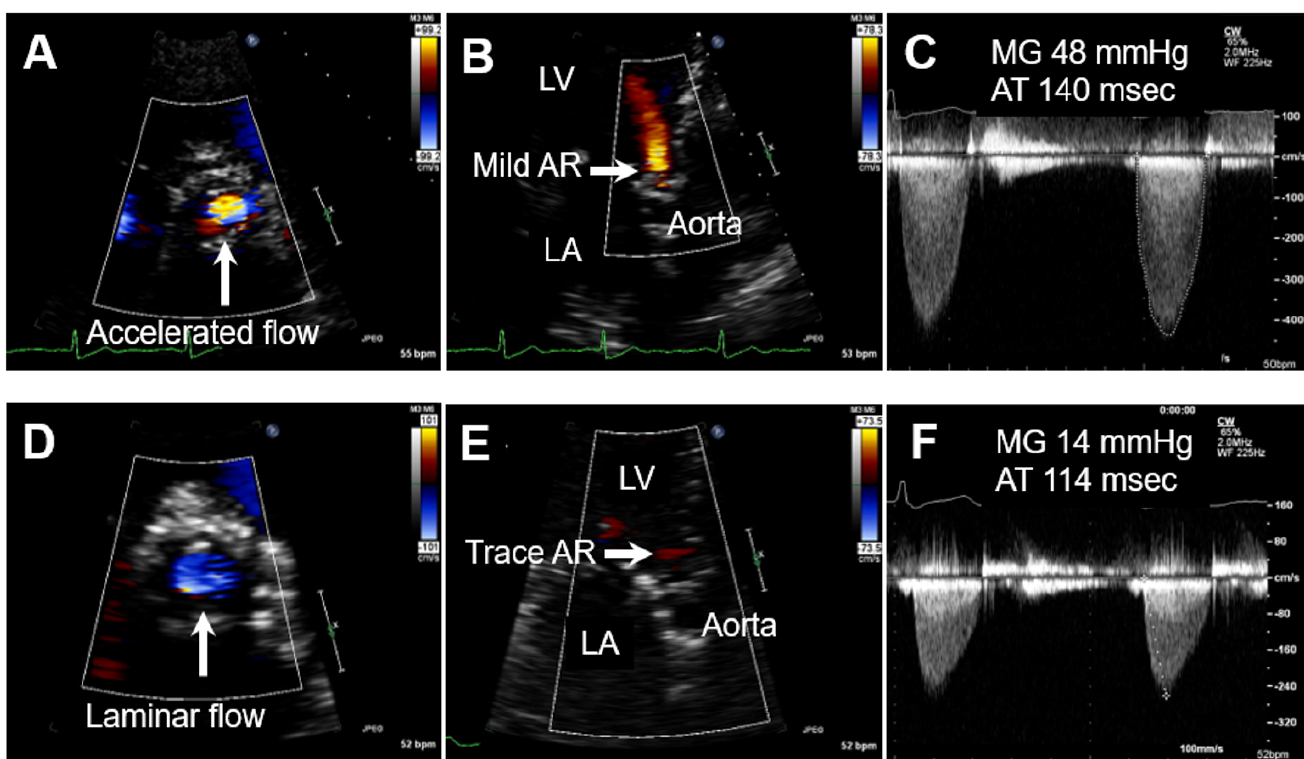
Figure 1. Transthoracic echocardiogram with CW Doppler before ( A – C ) and after ( D – F ) warfarin course (note virtually identical CW Doppler settings). ( A ) Short axis view demonstrating significant flow acceleration through the aortic prosthesis; ( B ) apical-axis view demonstrating mild aortic regurgitation (LV: left ventricle, LA: left atrium); ( C ) severely increased mean transvalvular gradient (MG) of 48 mmHg with prolonged acceleration time (AT) 140 msec. ( D ) Laminar flow through the aortic valve; ( E ) near disappearance of aortic regurgitation; ( F ) decrease in MG to 14 mmHg and AT to 114 msec.